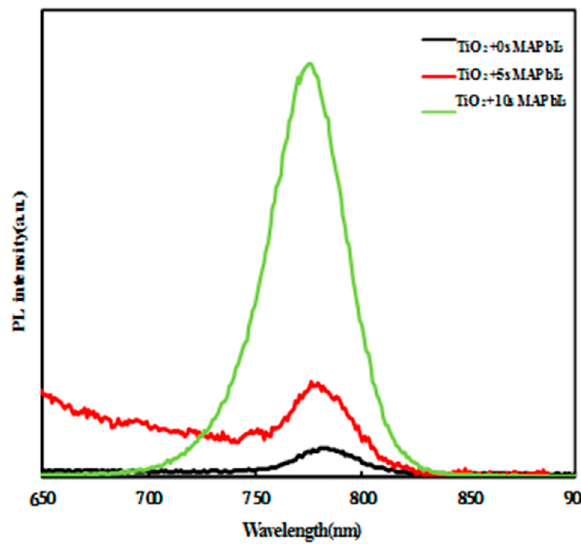
Figure 5. The photoluminescence (PL) spectra of light absorbing layer films with different delay times.